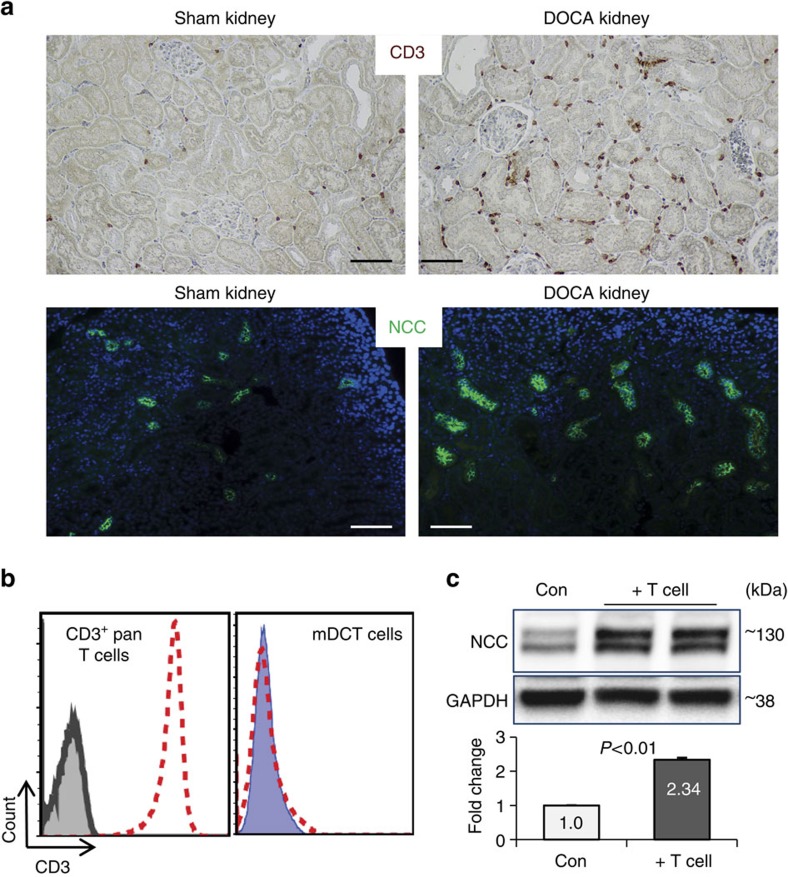
T cells accumulate in the kidney of DOCA mice and are associated with NCC up-regulation.(a) Immunostaining of pan T cell marker CD3 (brown, upper panels, scale 50 μm) or NCC (green, lower panels, scale 100 μm) on Sham or DOCA-salt treated mouse kidney sections. Nuclei were stained by hematoxyline (upper panels) or DAPI (lower panels). Data are representative of n=8 images in each group. (b) Left panel, isolated mouse splenic pan T cells were stained by CD3 antibody. Flow cytometry confirmed all cells were CD3+ T cells. Cells in grey closed area are T cells without CD3 staining as negative control; cells in red dashed line open area are T cells stained by CD3 antibody, indicating CD3+ T cells. Right panel, effects of using magnetic beads to remove T cells from the mDCT-T cell co-culture. Control mDCTs (before co-culture, blue closed area) and after co-culture mDCTs (after removal of T cells by using magnetic beads, red dashed line open area) were stained with CD3 antibody and analysed by flow cytometer. Data are representative of three independent tests. (c) Western blot analysis of NCC expression in mDCT cells with (+T cell) or without (Con) mouse splenic T cell-treatment. Two bands were detected for NCC, reflective of mature (upper) and immature (lower) forms (see methods). Quantitative western blot data were normalized using GAPDH as a loading control. n=4–5 in each group. Data are means±s.e. P<0.01 (t-test).